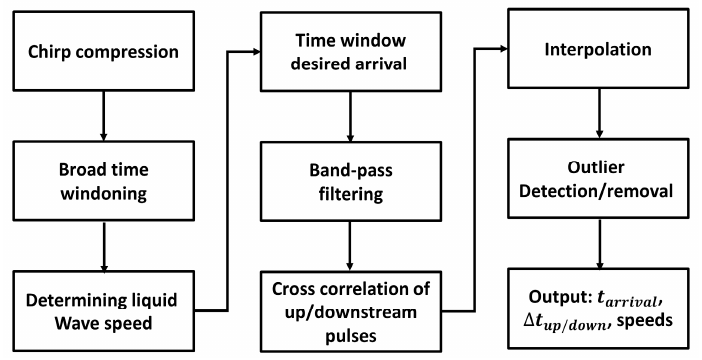
Figure 3. Scheme of the post-processing of ultrasonic signal.